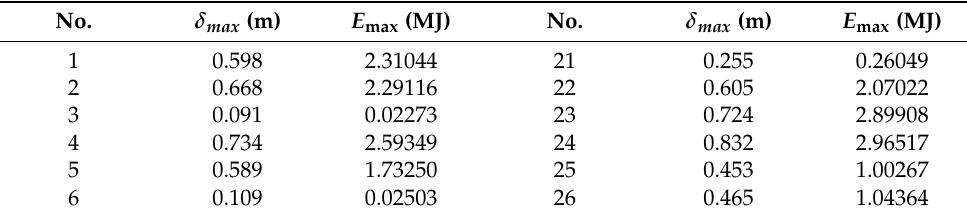
Table 7. Prediction results of DPSO-BP-ANN model for training samples.